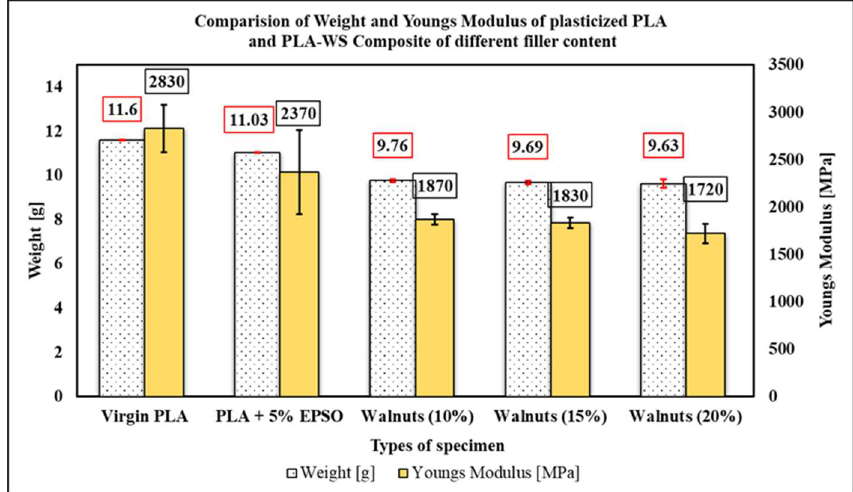
Figure 4. Tensile test result—Young’s modulus [MPa] comparison with weight [g].